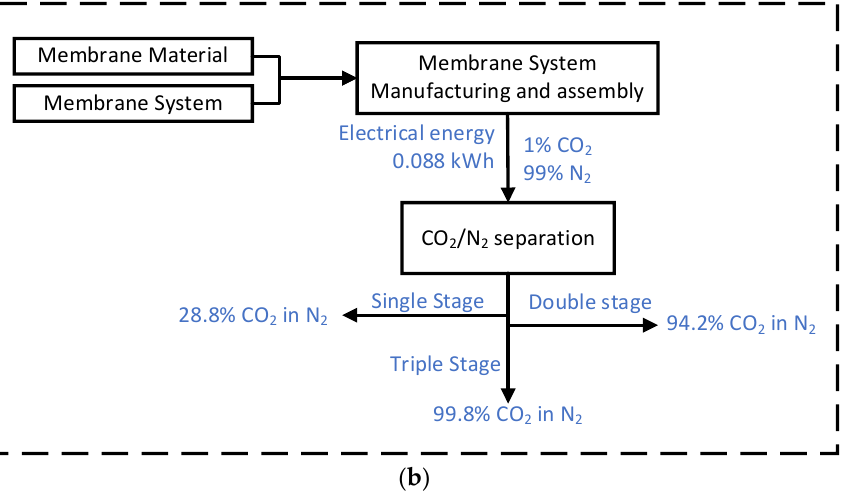
Figure 2. ( a ) Process flow diagram (PFD) of CO 2 enrichment system and ( b ) system boundary for the life cycle analysis.